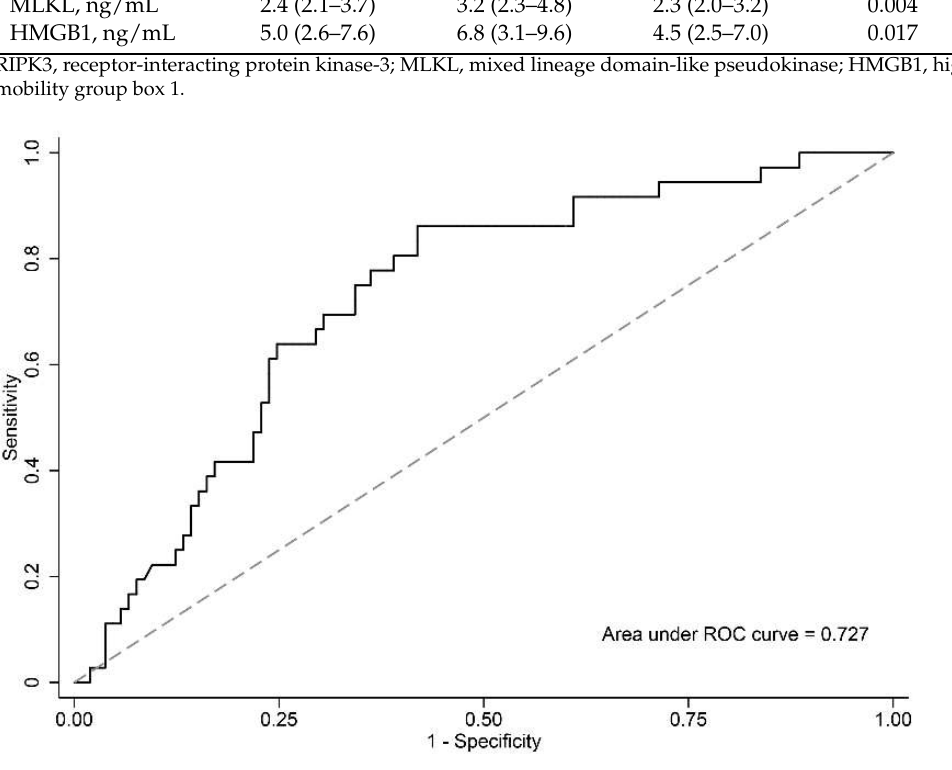
Figure 3. Receiver operating characteristic curve measuring the usefulness of mitochondrial DNA in predicting in-hospital mortality in critically ill patients with sepsis. The area under the